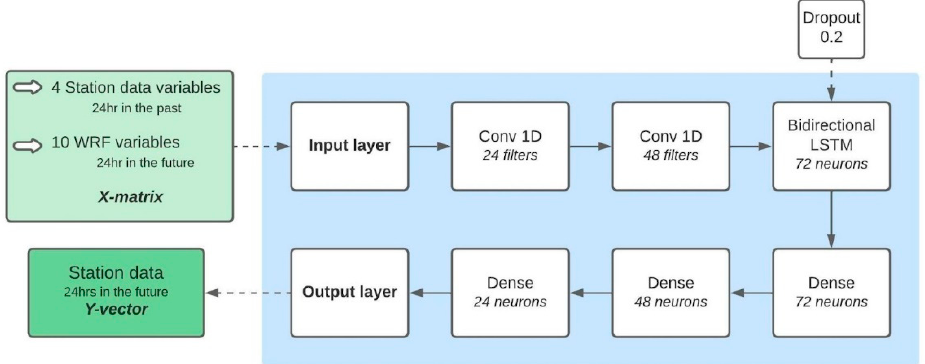
Figure 3. WRF-1D neural network structure. Notice that every box has the number of neurons/filters in the layer and that the dropout percentage of a layer is also indicated. The light green box shows the input variables (X-matrix) and the green box indicates the output the input variables (X-matrix) and the green box indicates the output (Y-vector).